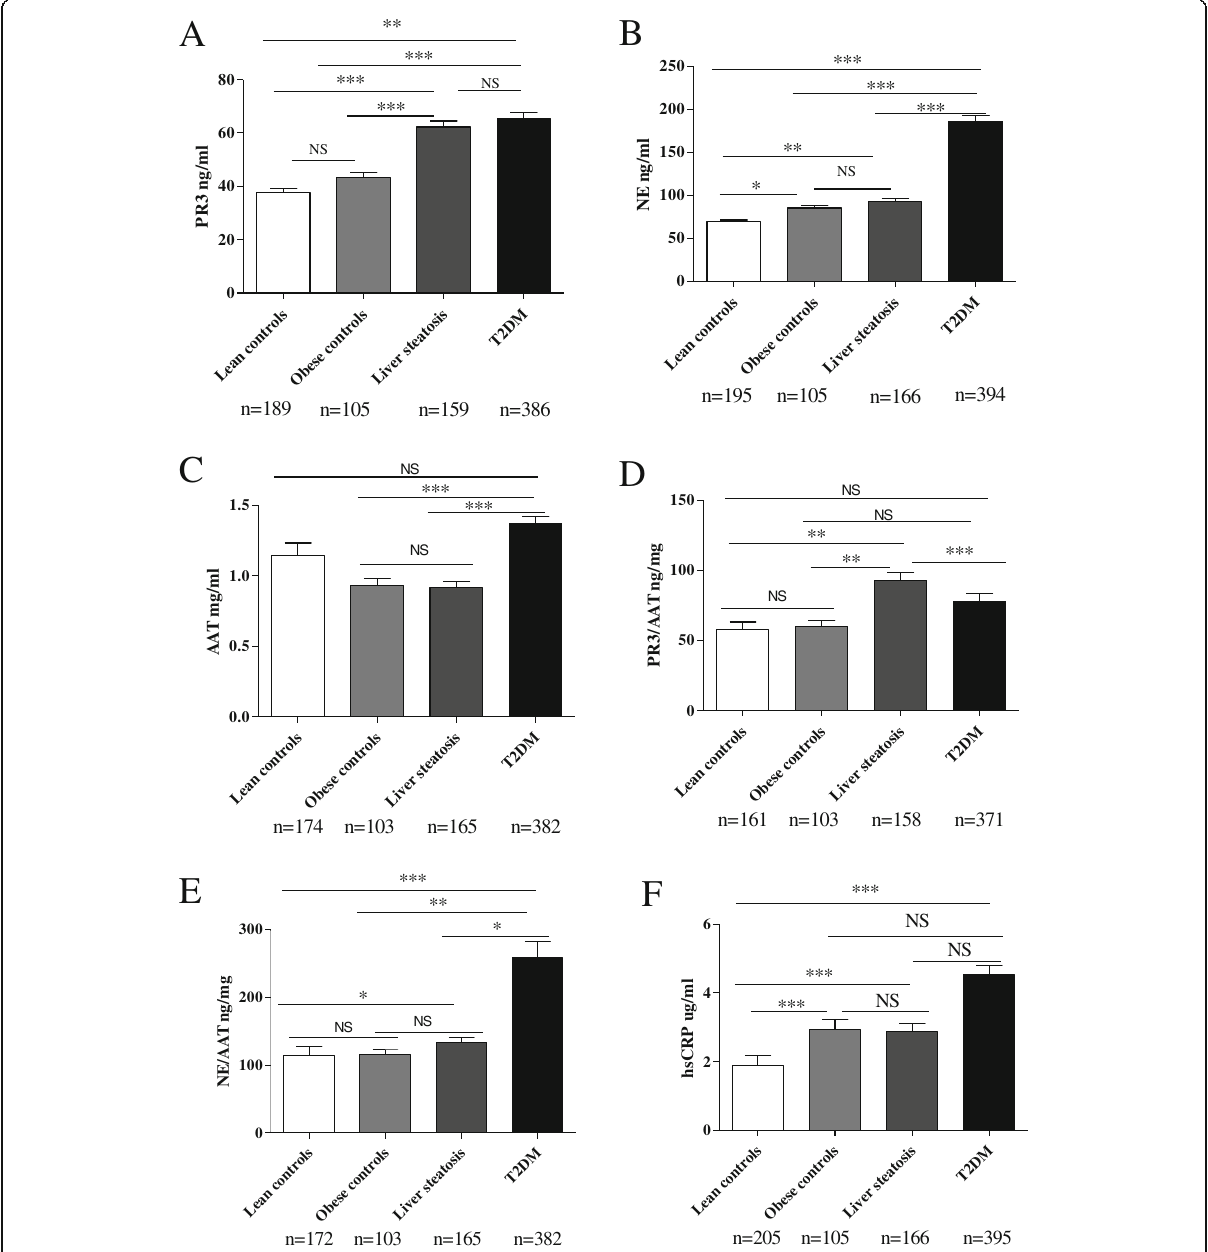
Fig. 1 PR3, NE, AAT and hsCRP plasma concentrations in patients with liver steatosis and type 2 diabetes versus lean and obese controls. a PR3 plasma concentrations in patients with liver steatosis and type 2 diabetes versus lean and obese controls. b NE plasma concentrations in patients with liver steatosis and type 2 diabetes versus lean and obese controls. c AAT plasma concentrations in patients with liver steatosis and type 2 diabetes versus lean and obese controls. d PR3 to AAT ratio in patients with liver steatosis and type 2 diabetes versus lean and obese controls. e NE to AAT ratio in patients with liver steatosis and type 2 diabetes versus lean and obese controls. f hsCRP concentrations in patients with liver steatosis and type 2 diabetes versus lean and obese controls. Data is represented as mean ± SEM. * p < 0.05, ** p < 0.01, *** p < 0.001, NS = p >